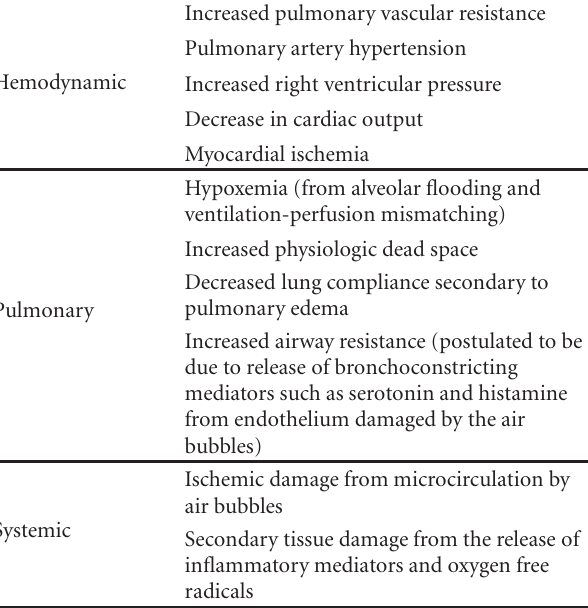
Table 2: Complications of venous air